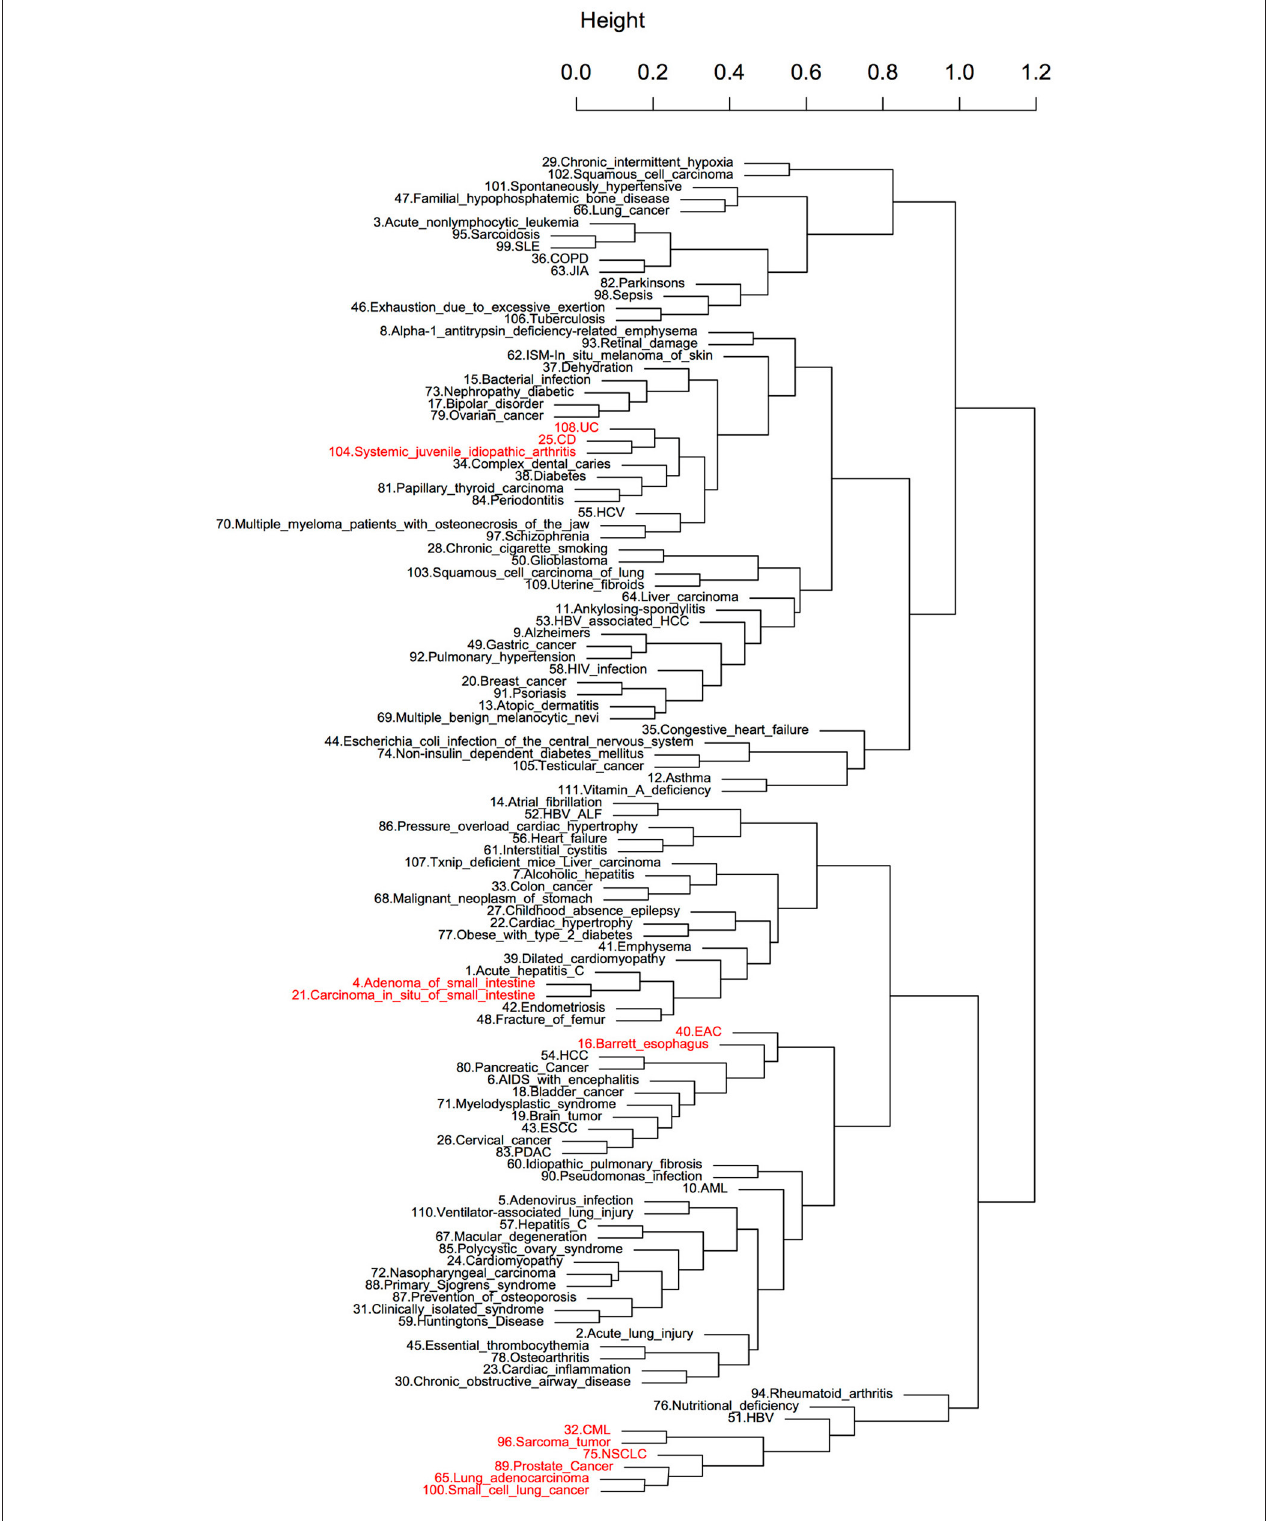
FIGURE 2 | Hierarchical clustering of diseases using diet-disease enrichment scores. The number before each disease name was used as a disease ID. The clustering is based on the enrichment scores of diseases across all foods. The clusters highlighted with red are known to share characteristic pathophysiology.